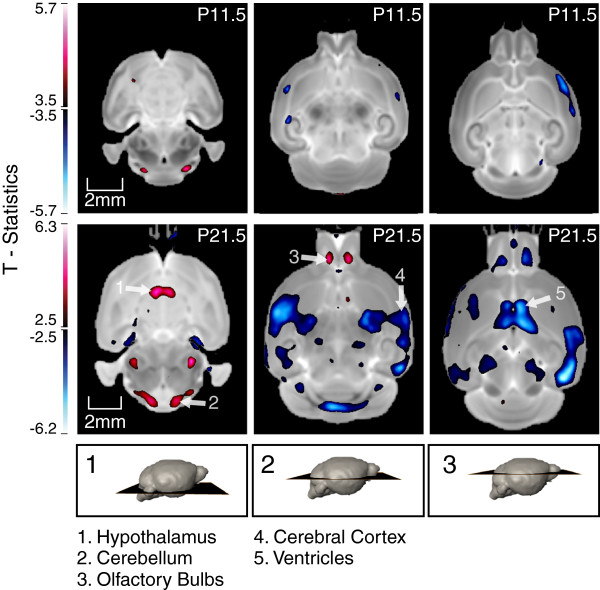
T-statistics map overlaid on top of the final average registered P11.5 and P21.5 brain images, highlighting voxels with statistically different deformation (FDR ≤ 15%). Blue regions are statistically smaller, whereas red regions are statistically larger in relative volume in the SD compared with the KD brain. Shown are three cross-sectional views of the average P11.5 brains, along with the corresponding cross-sections at P21.5, for comparison.